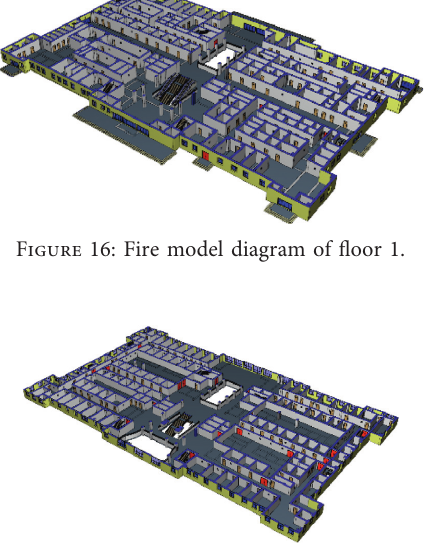
Figure 17: Fire model diagram of floor 2.